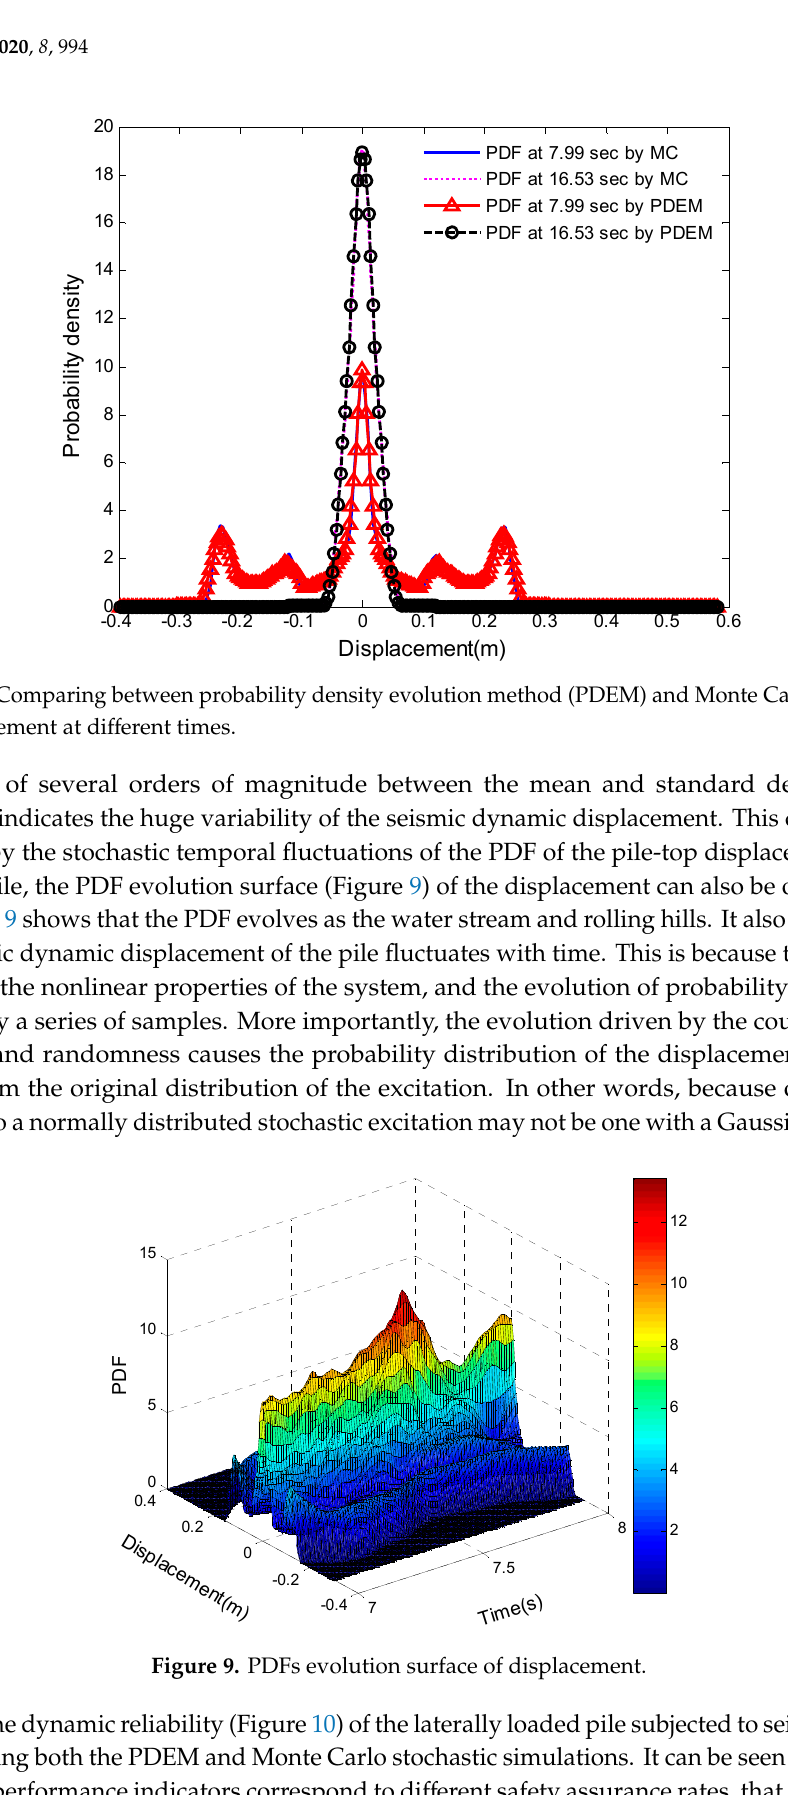
Figure 7. Mean and variance time histories of pile displacement.